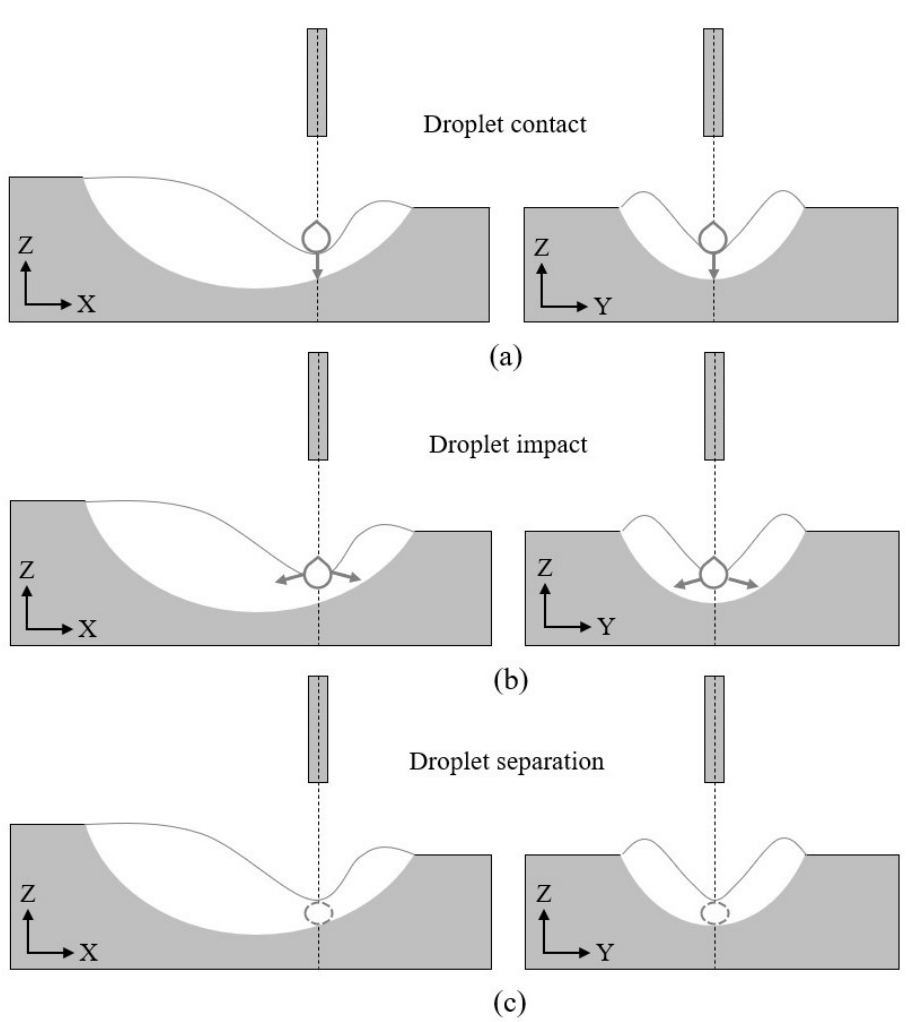
Figure 7. Process of droplet impact ( a ) the moment of droplet contact; ( b ) the moment of droplet impact; ( c ) the moment of droplet separation.